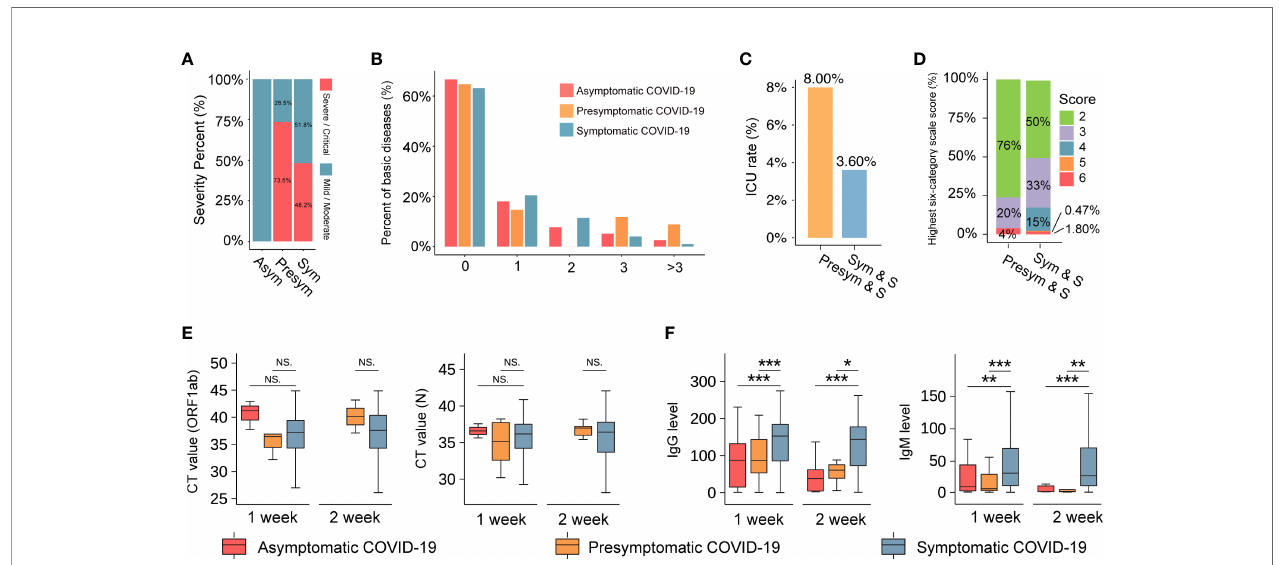
FIGURE 2 | The basic information of the COVID-19 cohort. (A) The severity percentage of asymptomatic, presymptomatic, and symptomatic patients with COVID-19. Blue represents non-severe (mild or moderate), and red represents severe or critical. (B) The comorbidity rate of patients with COVID-19. The vertical axis represents the percentage of comorbidities (%). The horizontal axis represents the number of comorbidities one patient has. (C) A comparison of the ICU rate between patients with presymptomatic and symptomatic severe COVID-19. The vertical axis indicates the rate of ICU. ‘ Pre-sym & S ’ and ‘ Sym & S ’ represent the severe presymptomatic and symptomatic patient group, respectively. (D) The highest six-category scale scores in severe COVID-19 patients. The vertical axis indicates the number of highest six-category scale scores (%). Scores represent their severity, including 1-discharged, 2-hospitalization without requiring oxygen therapy, 3-hospitalized with low- fl ow oxygen therapy, 4-hospitalized with non-invasive ventilation and/or high- fl ow oxygen therapy, 5-hospitalized for ECMO and/or mechanical ventilation, and 6-death. (E) and (F) The boxplot re fl ects the viral load (CT value) and SARS-COV-2 antibody IgG and IgM levels in three groups at 1 week or 2 weeks after admission. *** represents P -value < 0.001. ** represents P -value < 0.01. * represents P -value < 0.05. NS. represents P -value > 0.05. The three colors of red, orange and blue represent the asymptomatic, presymptomatic, and symptomatic group,